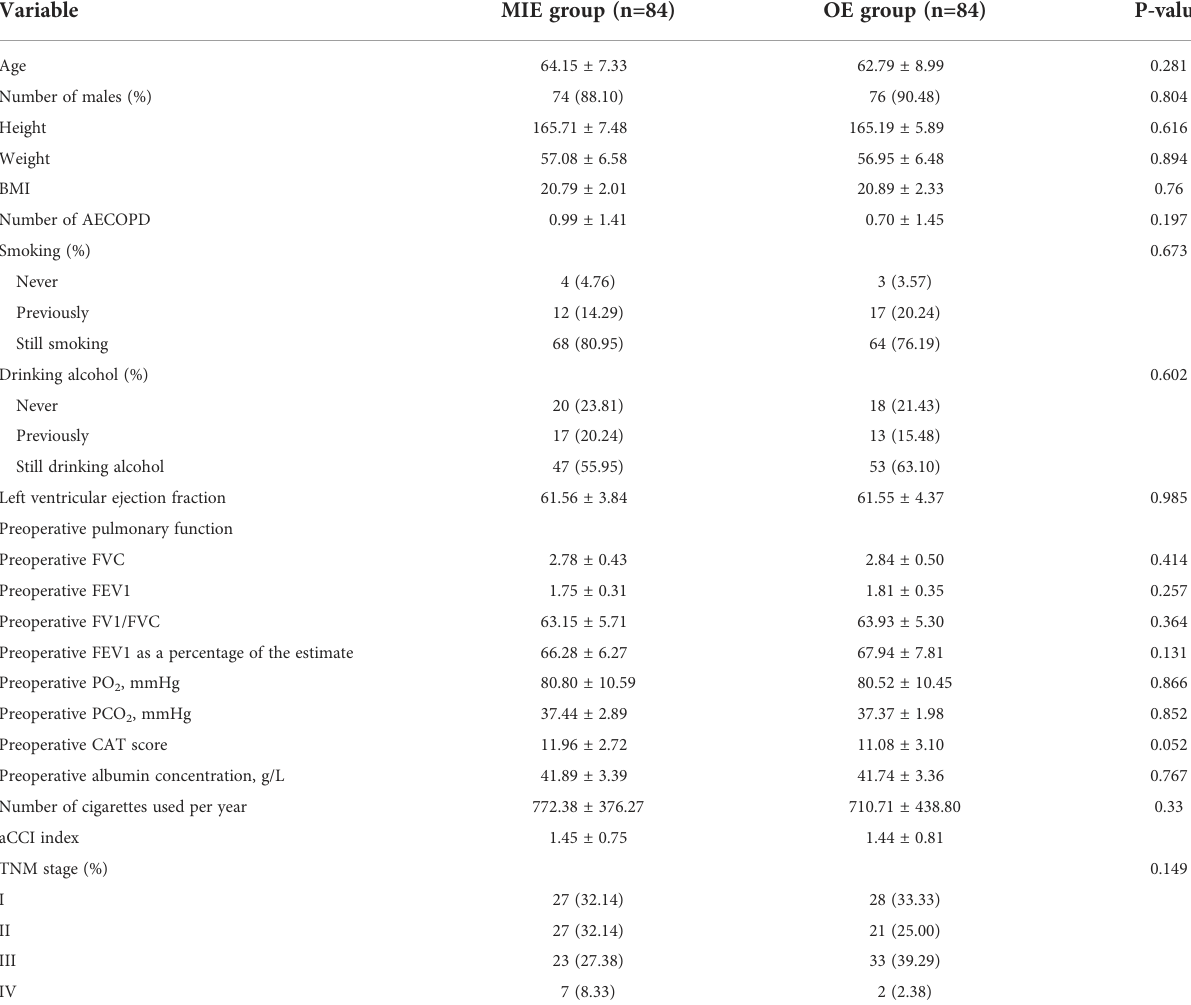
TABLE 2 Baseline data after